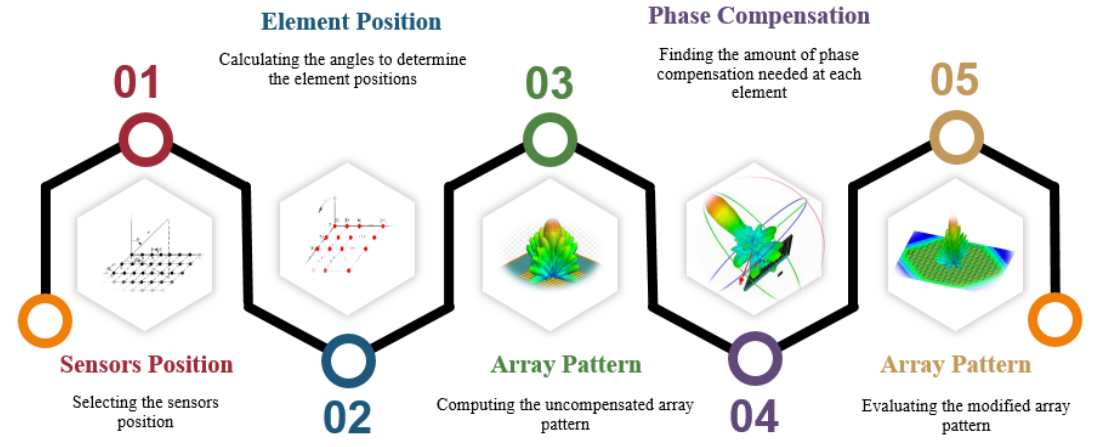
Figure 4. Steps to evaluate the antenna array response of a flexible or curved array.